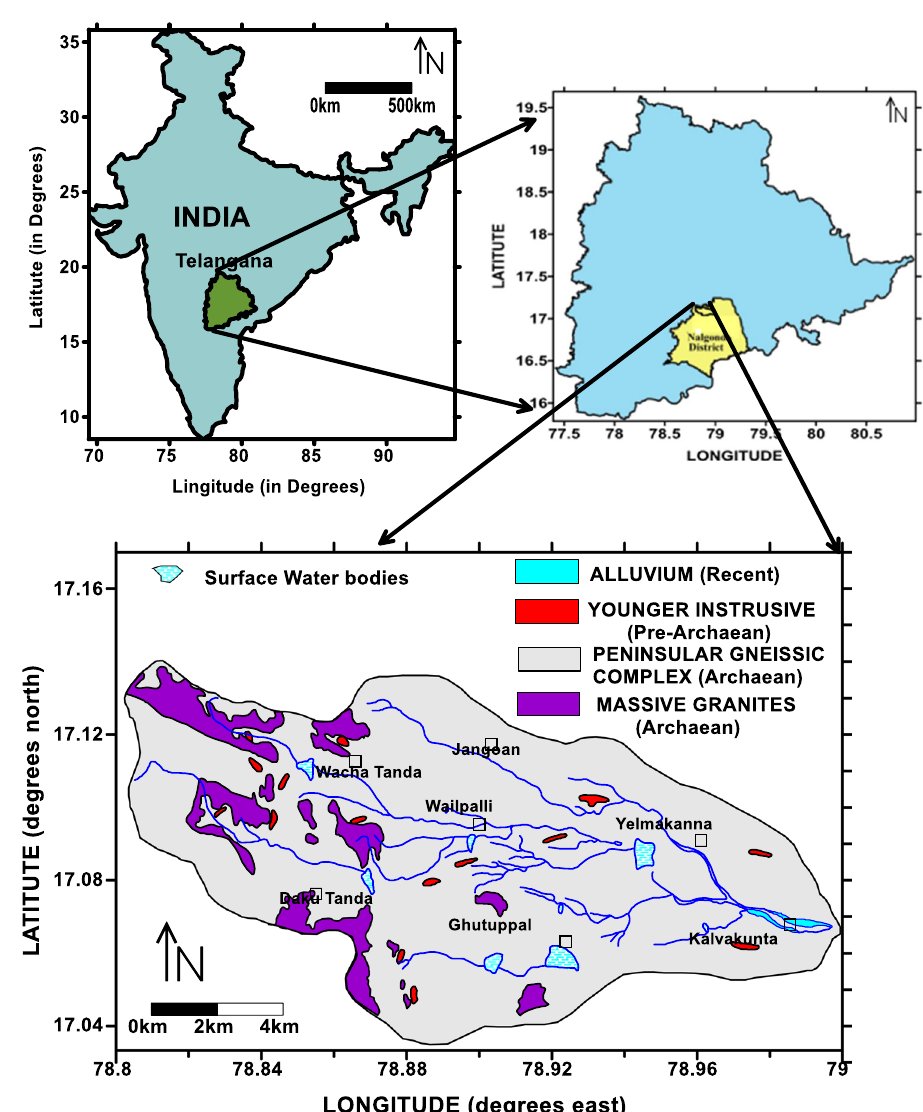
Fig. 1 Key map showing geol- ogy of the